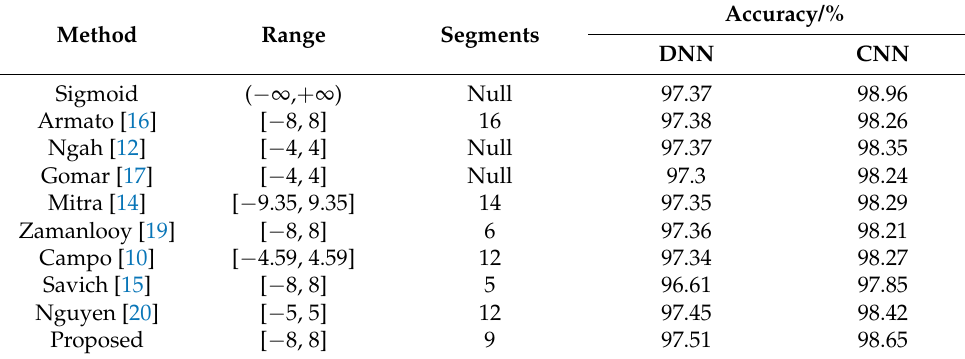
Table 8. Accuracies of DNN and CNN with different fitting